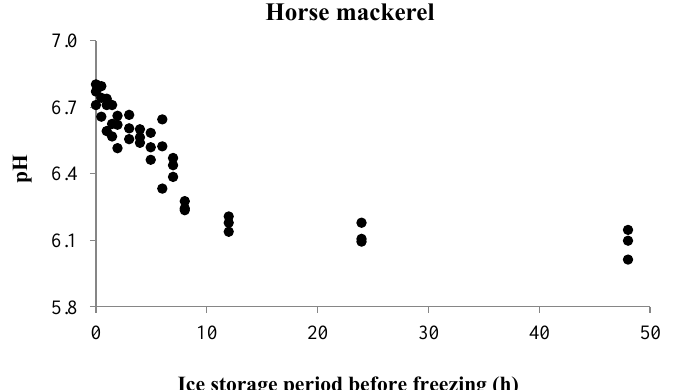
Figure 2. Changes in pH of frozen horse mackerel fillets previously stored for different ice-storage periods.